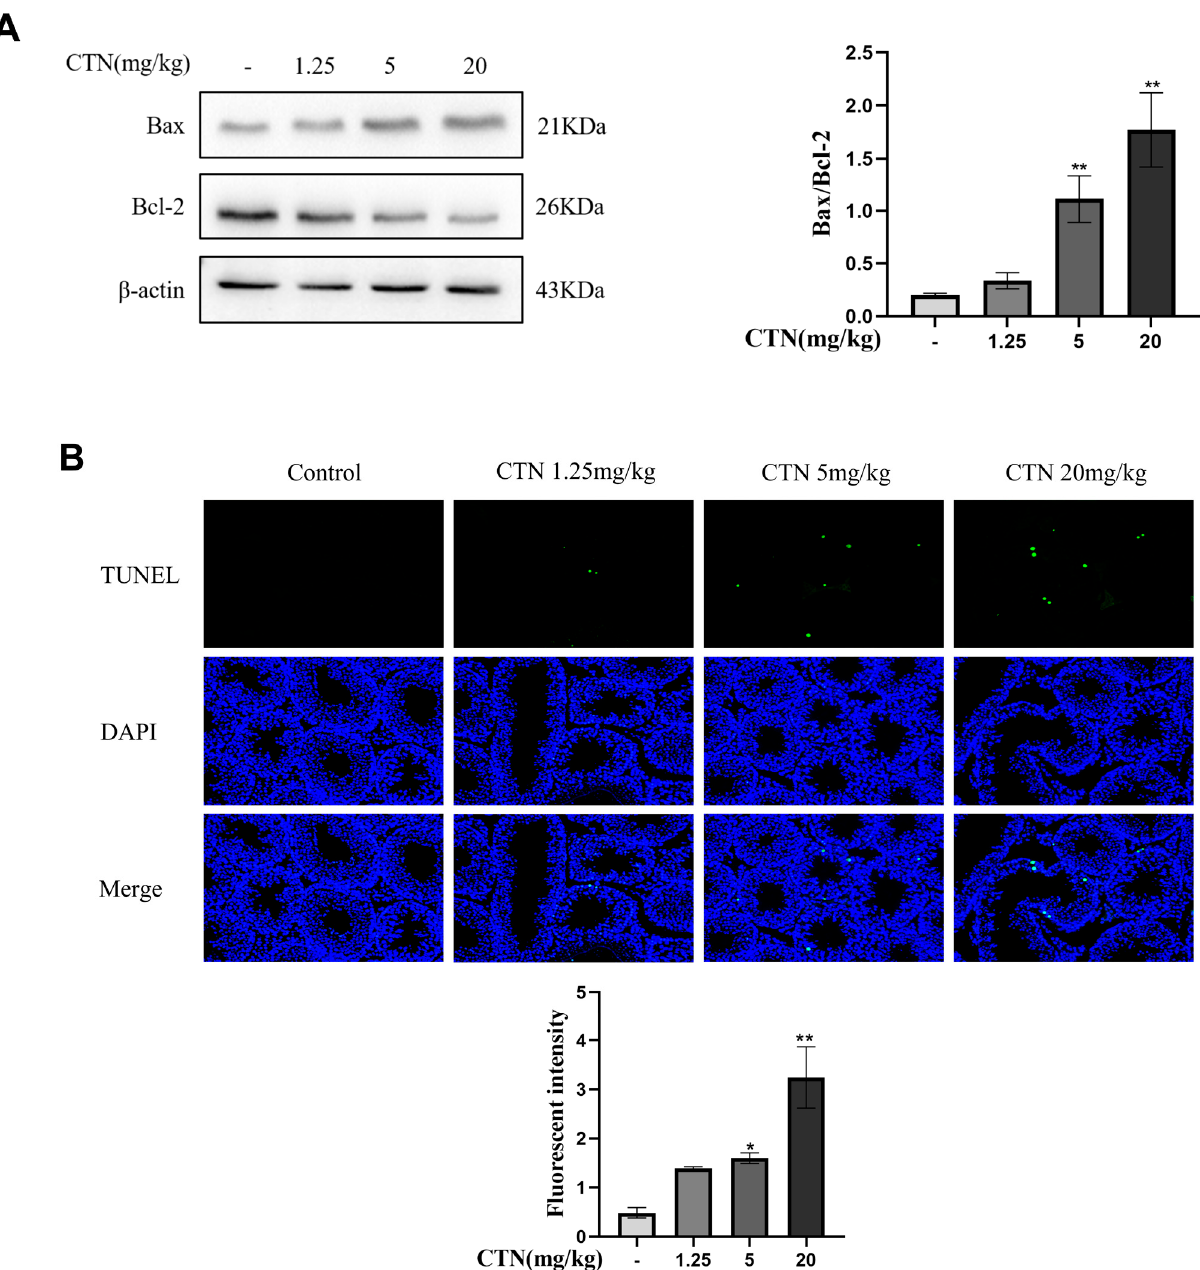
Figure 4. Effects of CTN on apoptosis of testicle cells in mice. ( A ) Bax and Bcl-2 protein expression levels; ( B ) TUNEL assay for testicular apoptosis (scale bar: 100 µm); the above data are expressed as SEM ± mean, compared with the control group, * p < 0.05, ** p < 0.01. 3.5. E ff ects of 4-PBA on Testicular ERS and Ultrastructural Changes after CTN Exposure